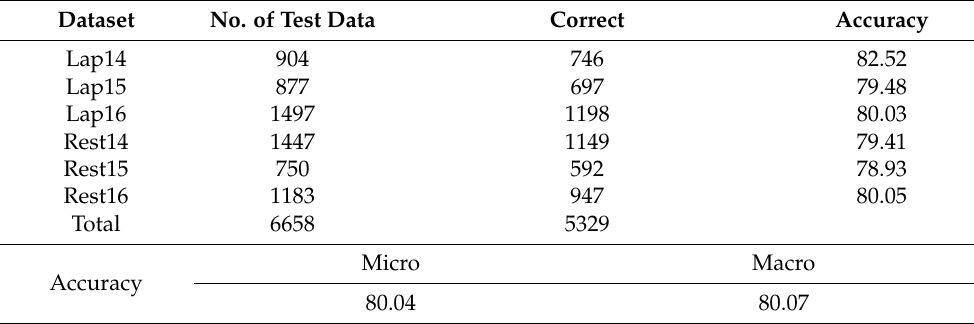
Table 5. Performance for holder extraction (Task